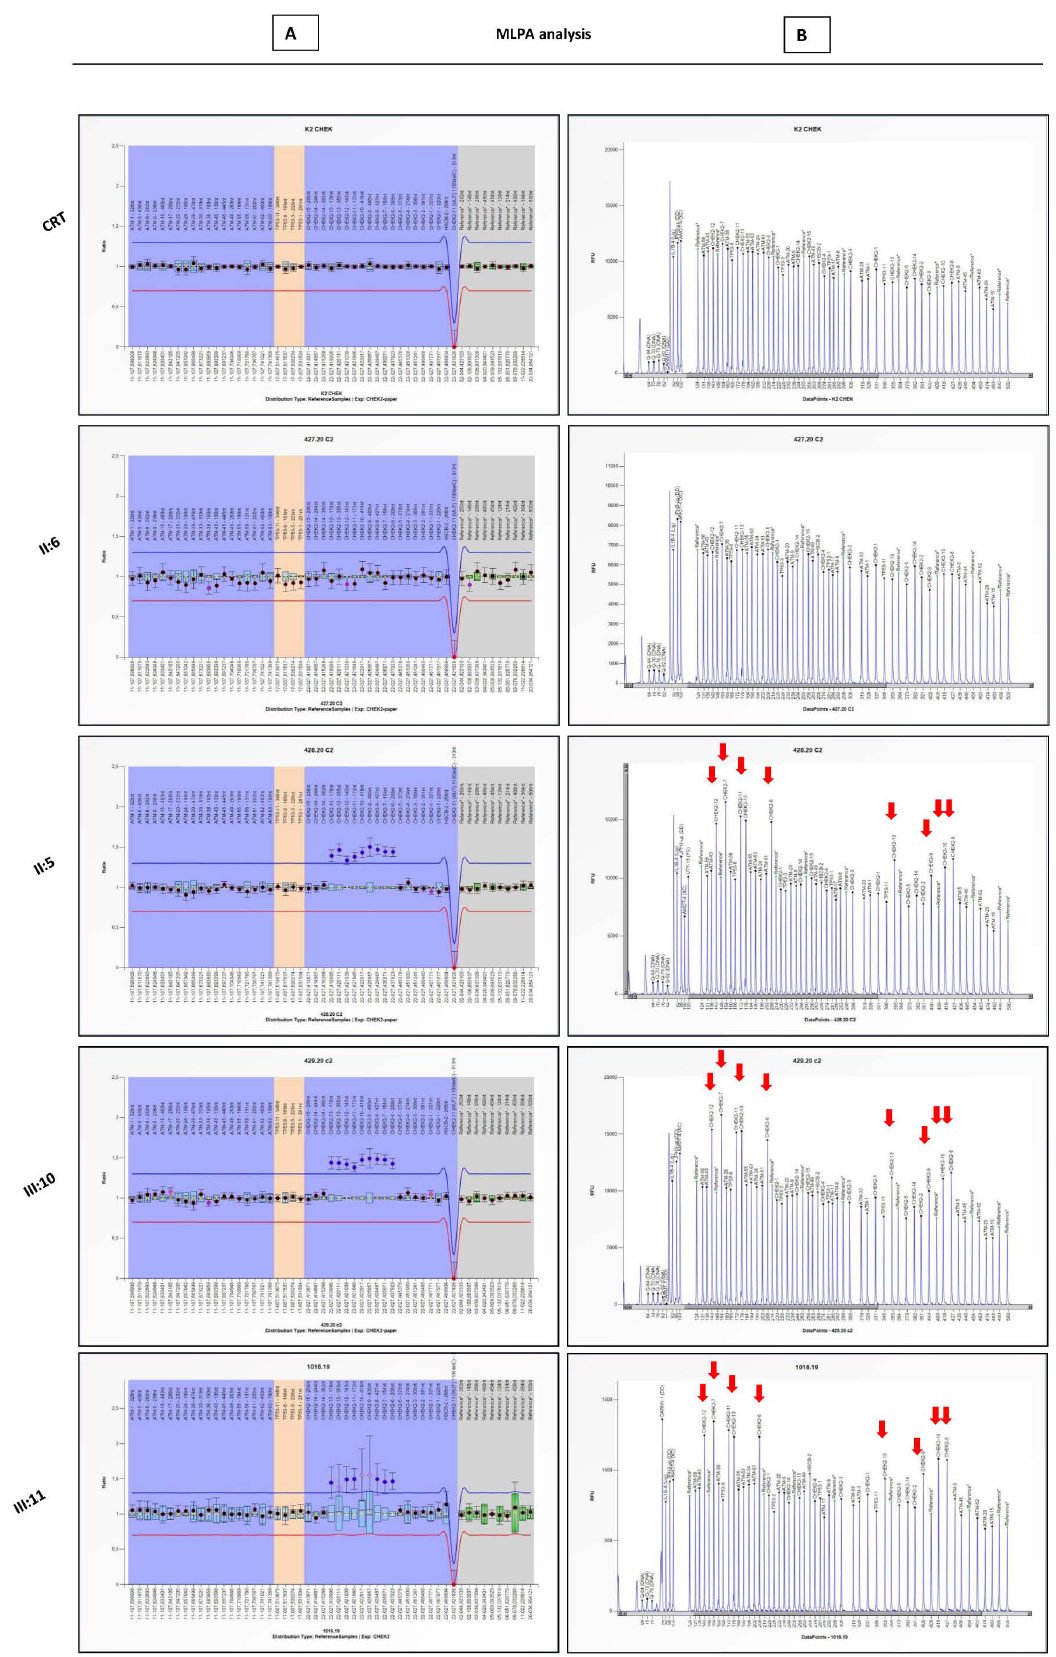
Figure 3. CHEK2 MLPA with CHEK2 P190-D1 kit on proband and first-degree relatives. ( A ) In